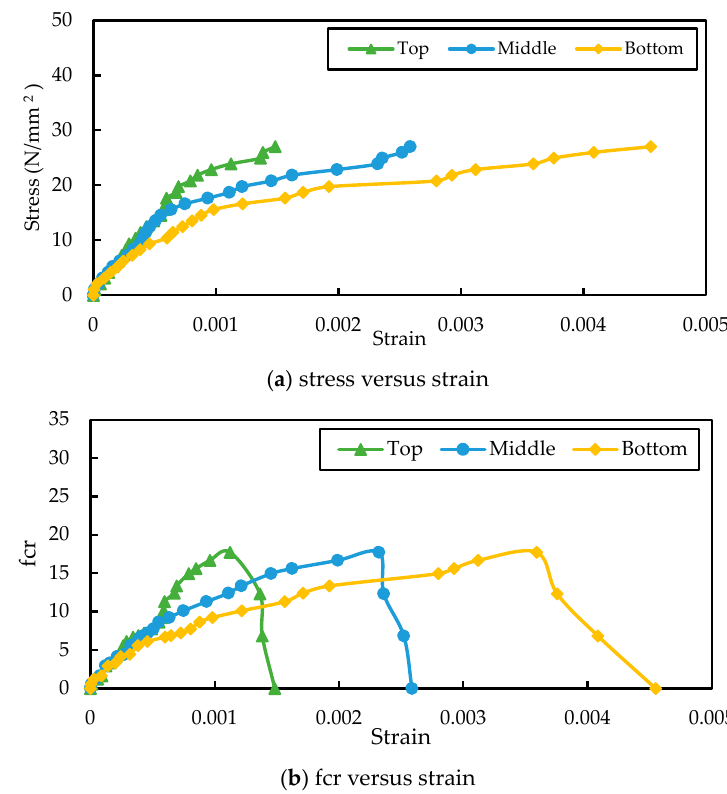
( b ) fcr versus strain